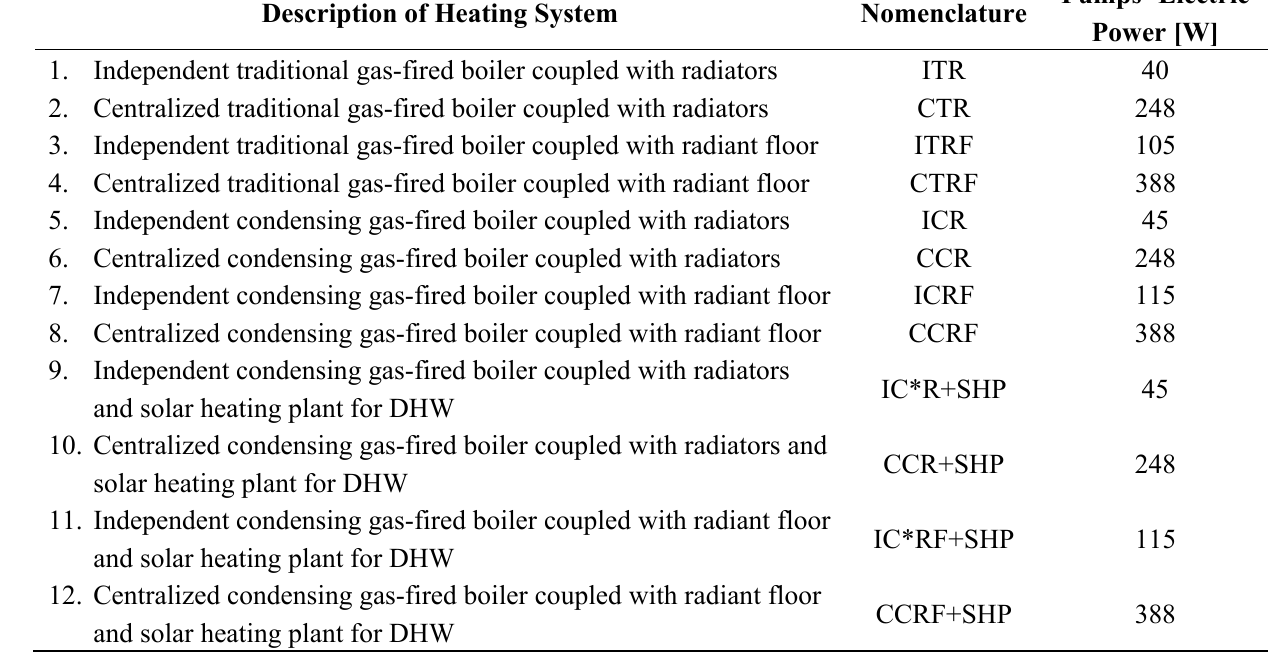
Table 3. Analyzed heating systems and electric pumps consumption for space